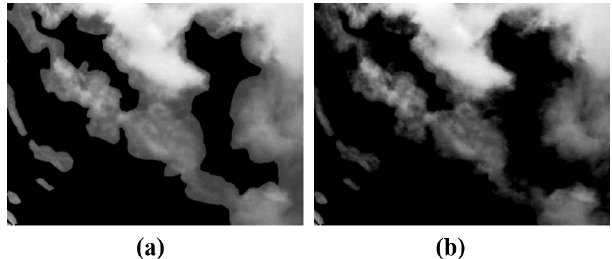
Figure 4. Comparison of cloud image. (a) Original grayscale image and (b) processed grayscale image.